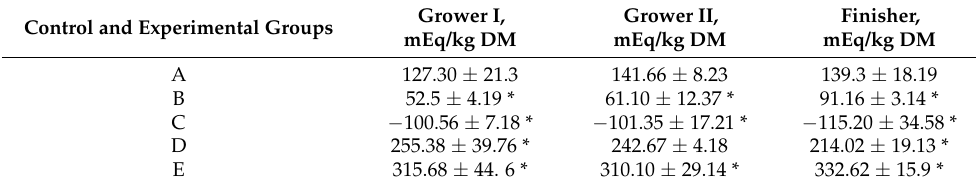
Table 3. Values of diet cation–anion differences obtained in the control and experimental turkeys.